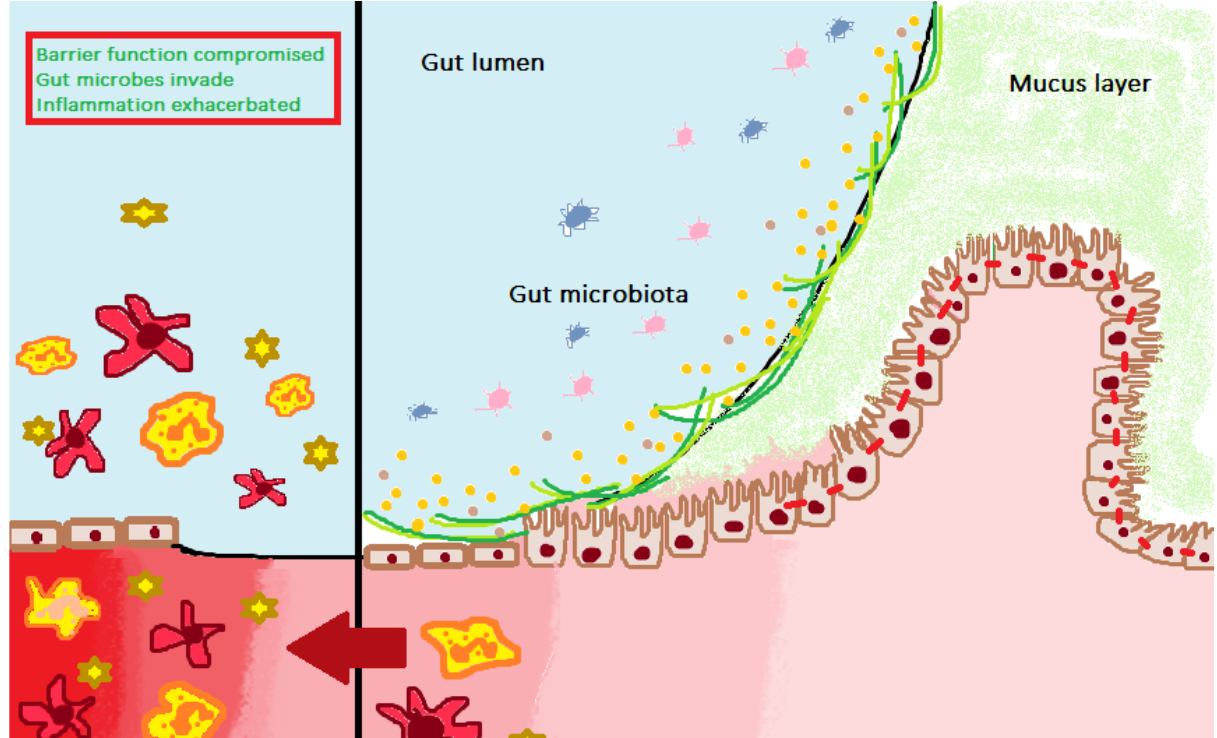
Figure 1. The human gastrointestinal tract is colonized by about 10 13 – 10 14 microorganisms, of which 15,000 different bac- terial strains are located mainly in the colon in a symbiotic relationship with the host. In normal conditions, the microbiota is characterized by the predominance of obligate anaerobic members of Firmicutes and Bacteriodetes phyla, which guar- antee intestinal and general health, while the loss of homeostasis, dysbiosis, linked to the proliferation of some bacterial populations such as the Enterobacteriaceae or the absence of important commensal bacteria helps to create a more favor- able environment for the growth of pathogens, predisposing the organism to pathological